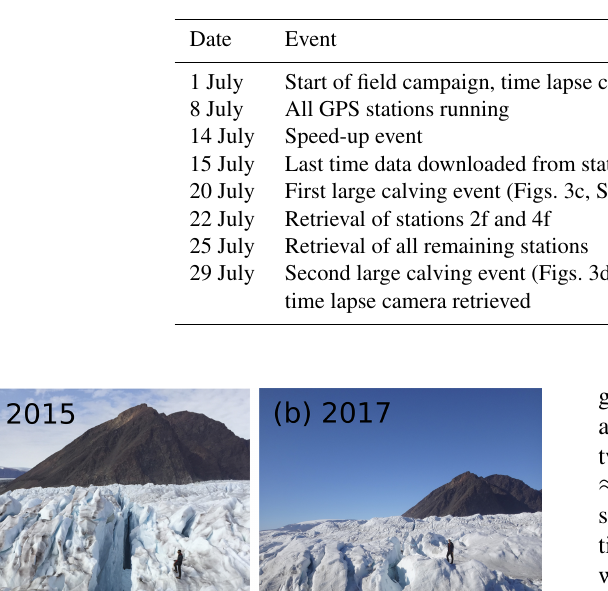
Figure 1. (a) Map of Bowdoin Glacier. The star in the upper left inset indicates the position of Bowdoin Glacier in Greenland (MODIS; ORNL DAAC, 2018), and the Copernicus Sentinel-2 satellite image shows Bowdoin Glacier on 1 July 2019. White dots show the positions of the time lapse camera and GPS base station. Front positions from 1973 to 2020 in varying colour (see legend), derived from satellite imagery (from 2015 derived from Sentinel-1; see Sect. 3.4; earlier positions from Sugiyama et al., 2015, and Sakakibara and Sugiyama, 2018). (b) Centre-line cross section of ocean bed, glacier bed, and glacier surface elevations as in summer 2013, including the front position in 2008 (Sugiyama et al., 2015). Table 1. Timeline of events during the 2019 field campaign.